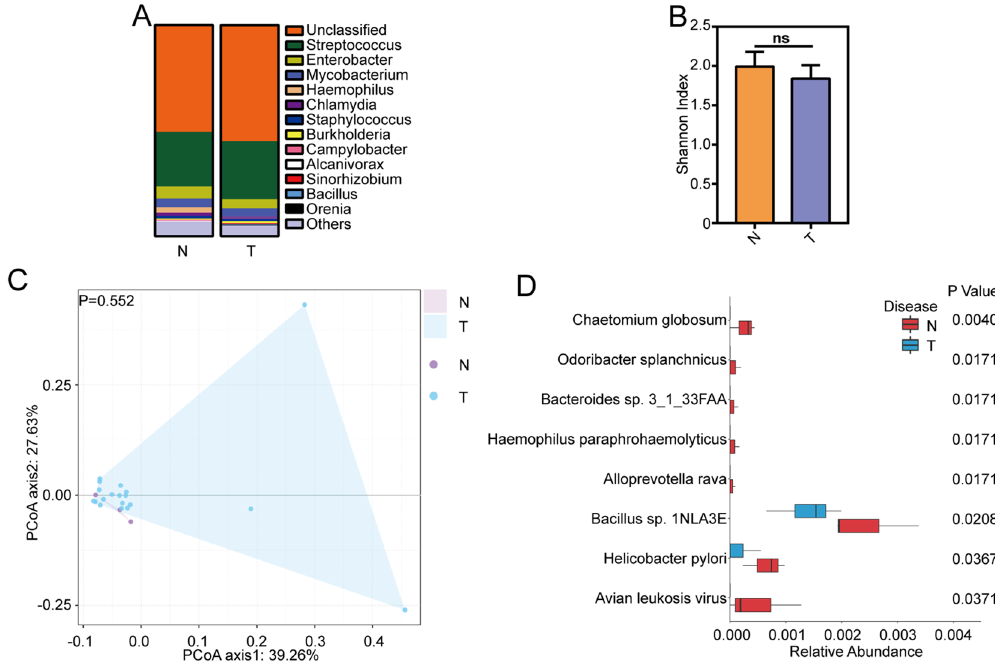
Figure 4. Microbiota composition of NSCLC patients and non-cancer controls in lobectomy samples. ( A ) Taxonomic composition of non-human sequences at phylum level in NSCLC patients and non-cancer controls in lobectomy samples. ( B ) The Shannon diversity index between NSCLC patients and non-cancer controls in lobectomy samples. Difference between sampling methods was determined by Student t test. NS no significance. ( C ) PCoA analysis of NSCLC patients and non-cancer controls in lobectomy samples. Anosim was performed to test statistically whether there is a significant difference. p < 0.05 was considered to be significant. ( D ) The differential species between NSCLC patients and non-cancer controls in lobectomy samples were identified by Wilcoxon rank-sum test (p < 0.05). N non-cancer controls, T NSCLC